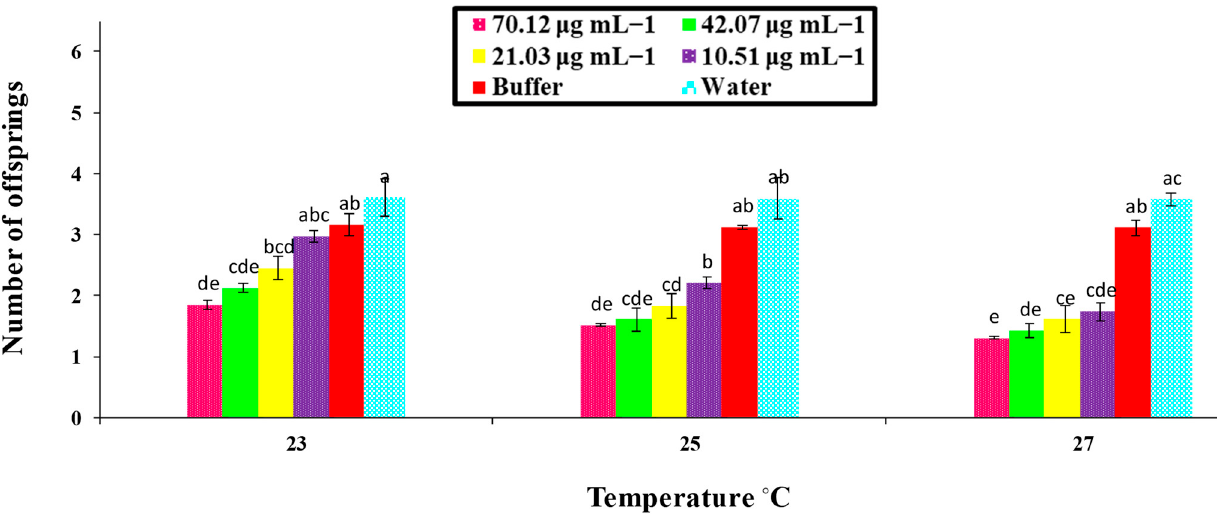
Figure 6. Average fecundity with ± SE of aphids ( M. persicae ) on chili plants with various PeBC1 elicitor protein changed concentrations at different altered temperature regimes ( n = 10); alphabet letters on each bar’s top show inequalities between treatments (factorial analysis one-way ANOVA; LSD at α = 0.05). Fecundity was reduced in PeBC1-treated seedlings.